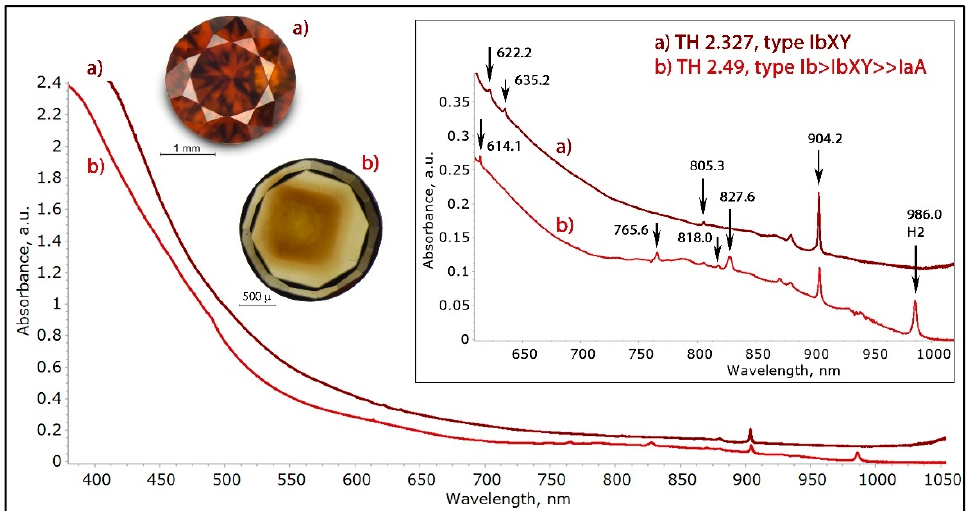
Figure 22. The low temperature UV-Vis-NIR spectra of the two hydrogen-rich mixed growth cuboid-octahedral type IbXY diamonds (samples TH 2.327 and TH 2.49). Such spectra are very different to